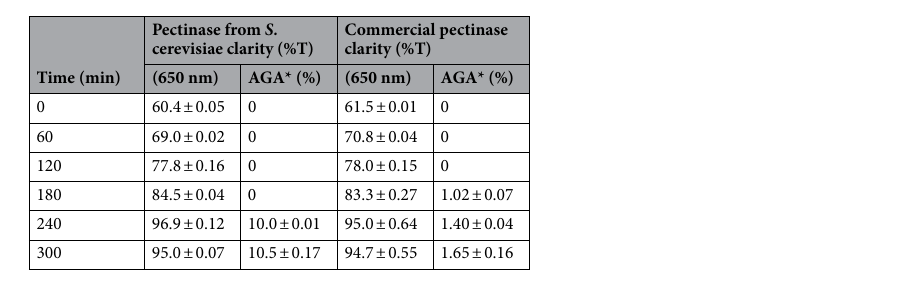
Table 3. Comparison of pectinase from S. cerevisiae and commercial pectinase in pectin degradation and clarification of banana juice at various incubation times at 35 °C. * AGA anhydrogalacturonic acid; mean ± SE (n =